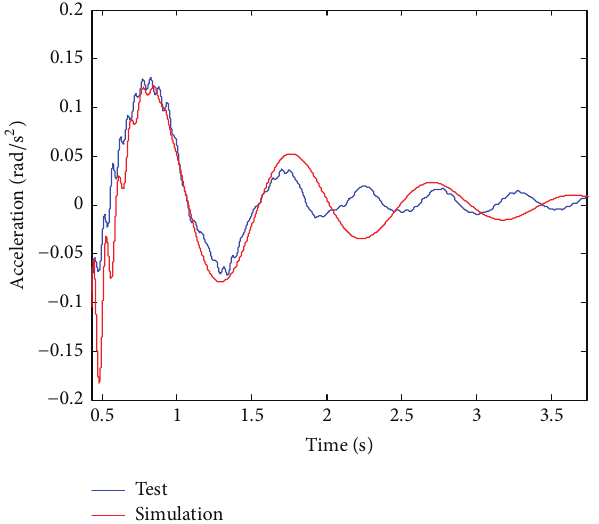
Figure 9: Comparison of the roll angle acceleration of testing with the one of simulation in roll